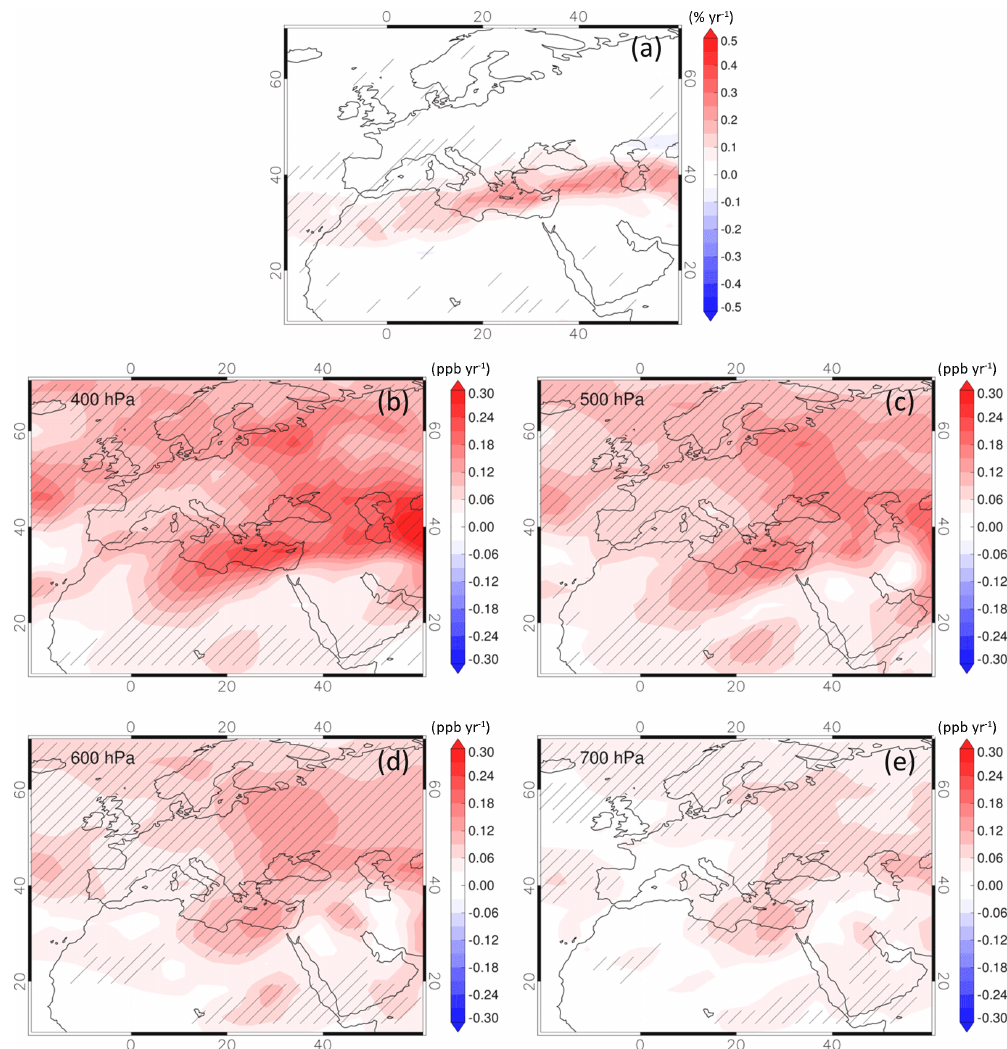
Figure 11. Trends of (a) JJA tropopause fold frequency (%yr − 1 ) and JJA EMAC-simulated O 3 s (ppbyr − 1 ) at (b) 400hPa, (c) 500hPa, (d) 600hPa and (e) 700hPa during the period 1979–2013. Areas featuring trends that are statistically significant at the 95% confidence level are